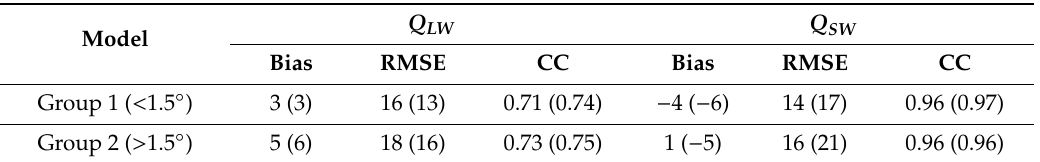
Table 3. Climatological bias, RMSE and CC (correlation) of Q LW and Q SW for high resolution (group 1 < 1.5 ◦ ) and low-resolution (group 2 > 1.5 ◦ ) models. A comparison was made over 30 ◦ S–30 ◦ N